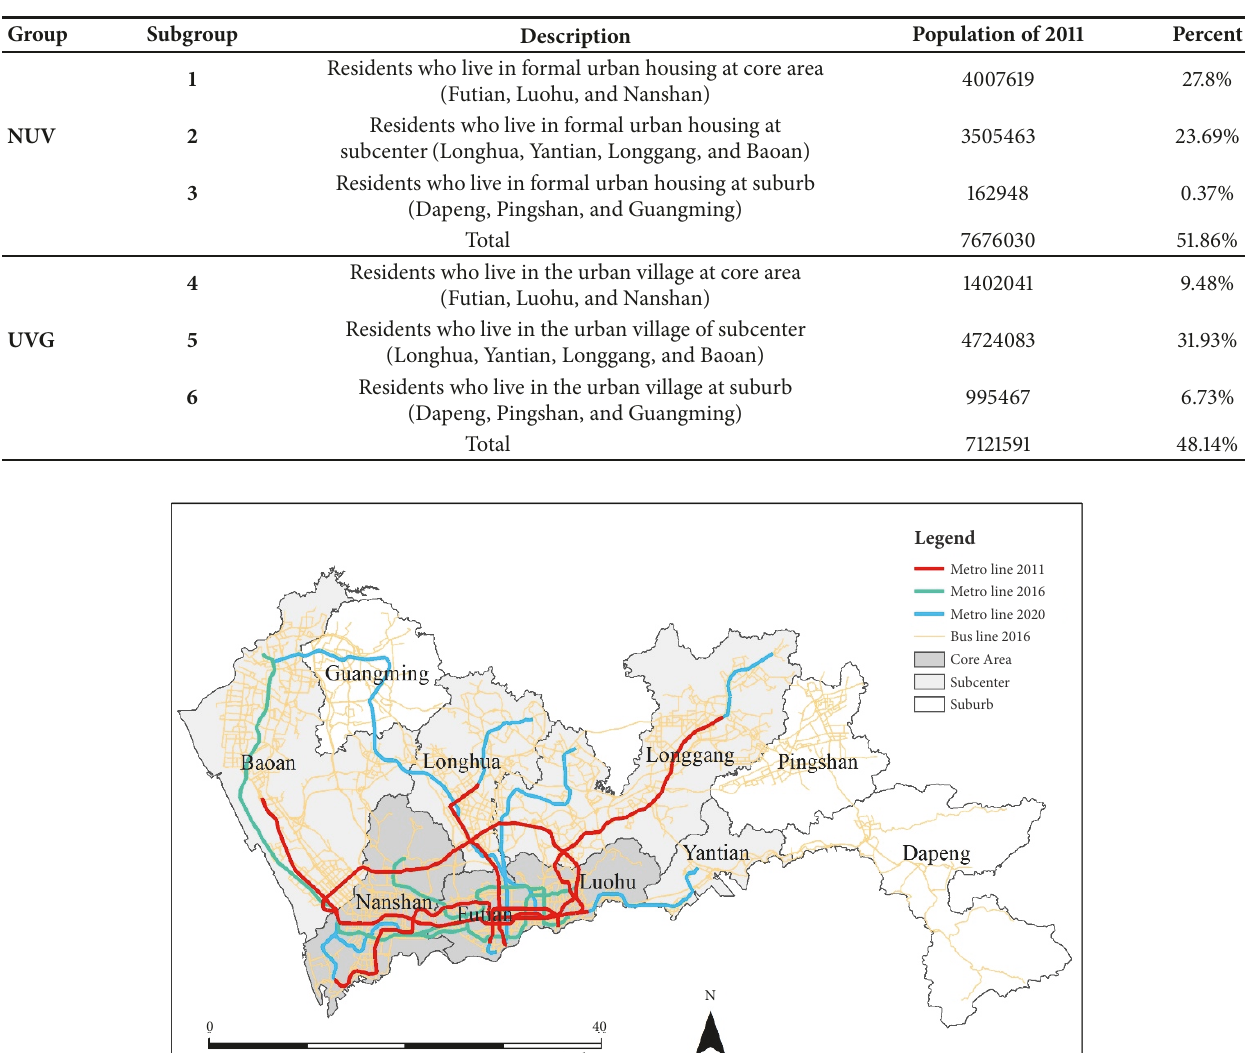
Table 2: Subgroups of NUV and UVG in Shenzhen.